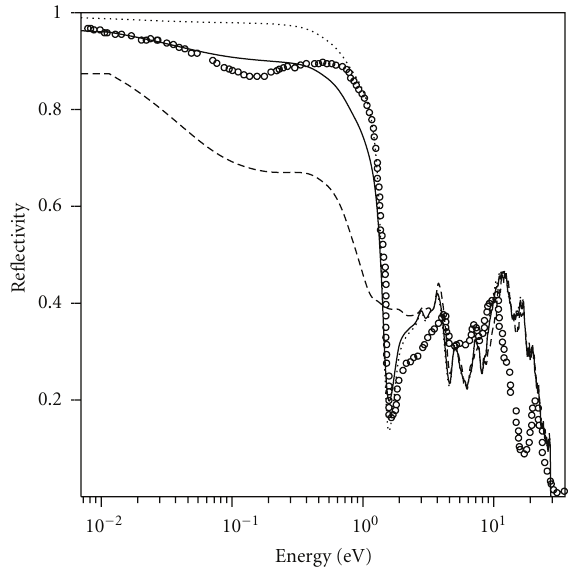
Figure 60: Calculated diagonal part of the optical conductivity σ 1 xx , of YbB 12 in the LSDA+ U approximation for Yb 2+ ion (full line) and Yb 3+ ion (dashed line) [349] compared with the experimental data (open circles)